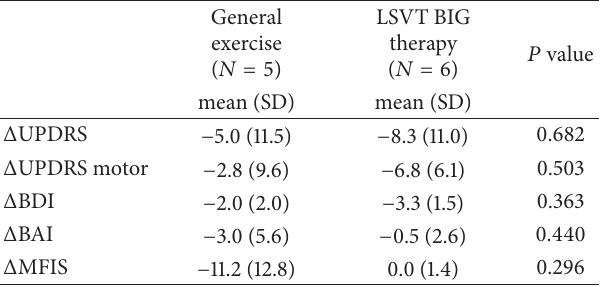
Table 3: Comparison between the two intervention groups at 6- month